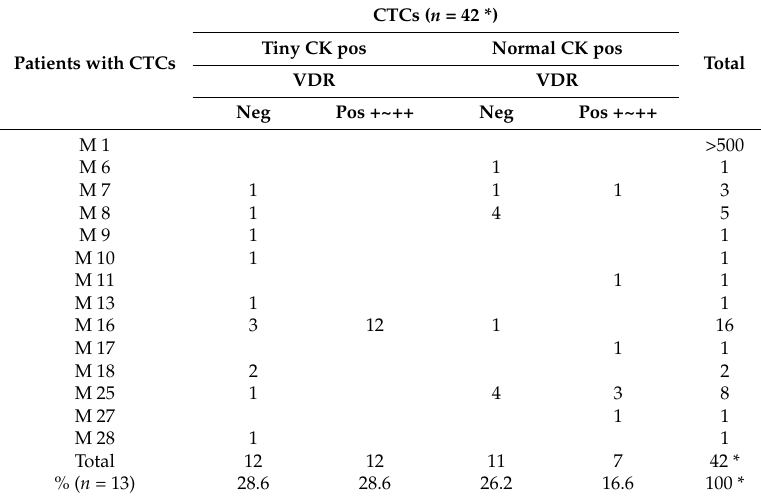
Table 3. Characteristics of the CTCs found in 14 patients. Patients with CTCs